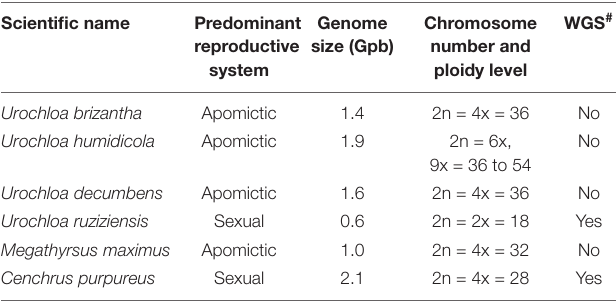
TABLE 1 | Reproductive system and genomic information of economically important tropical forage grasses used in livestock